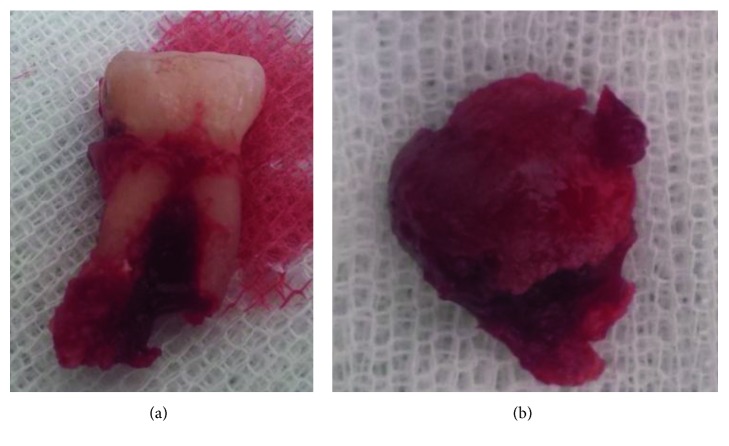
Biopsy specimen.